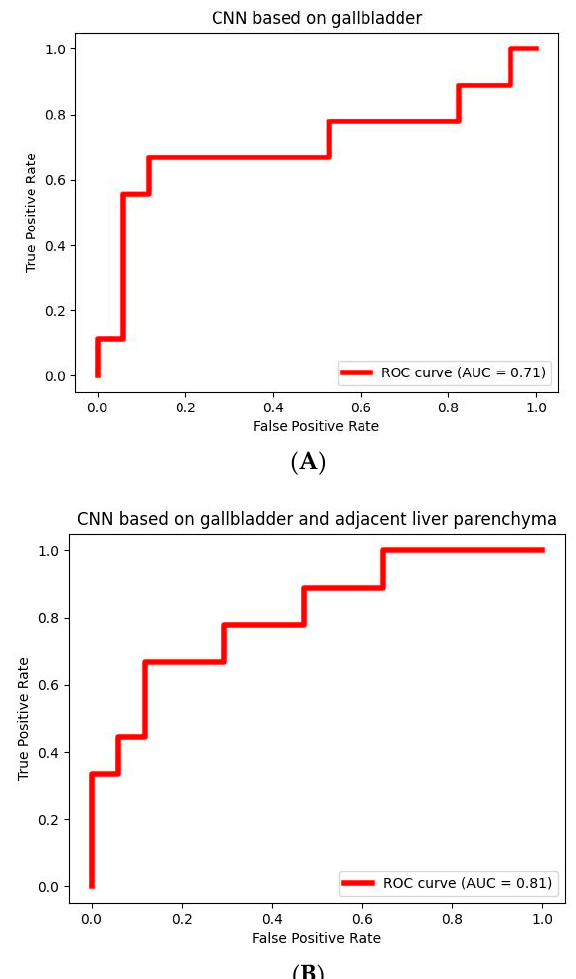
Figure 5. Receiver operating characteristic curves of the performance of the convolutional neural network on the test set. ( A ) CT-based convolutional neural network trained by only the gallbladder on the CT scan. ( B ) A CT-based convolutional neural network trained by the gallbladder including adjacent liver parenchyma on the CT scan.